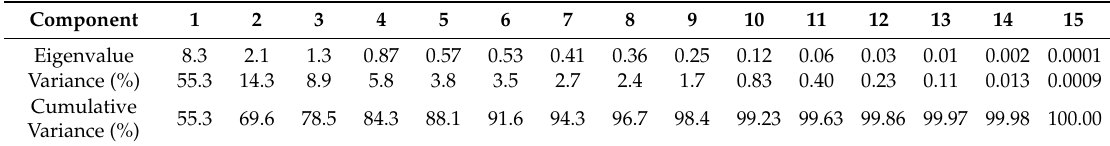
Figure 8. Scree plot for principal component analysis (Output: R Package). Table 3. Summary of the principal component analysis.